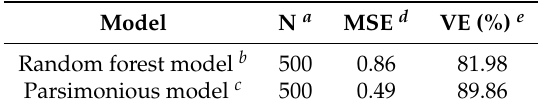
Table 1. Parameters of the random forest